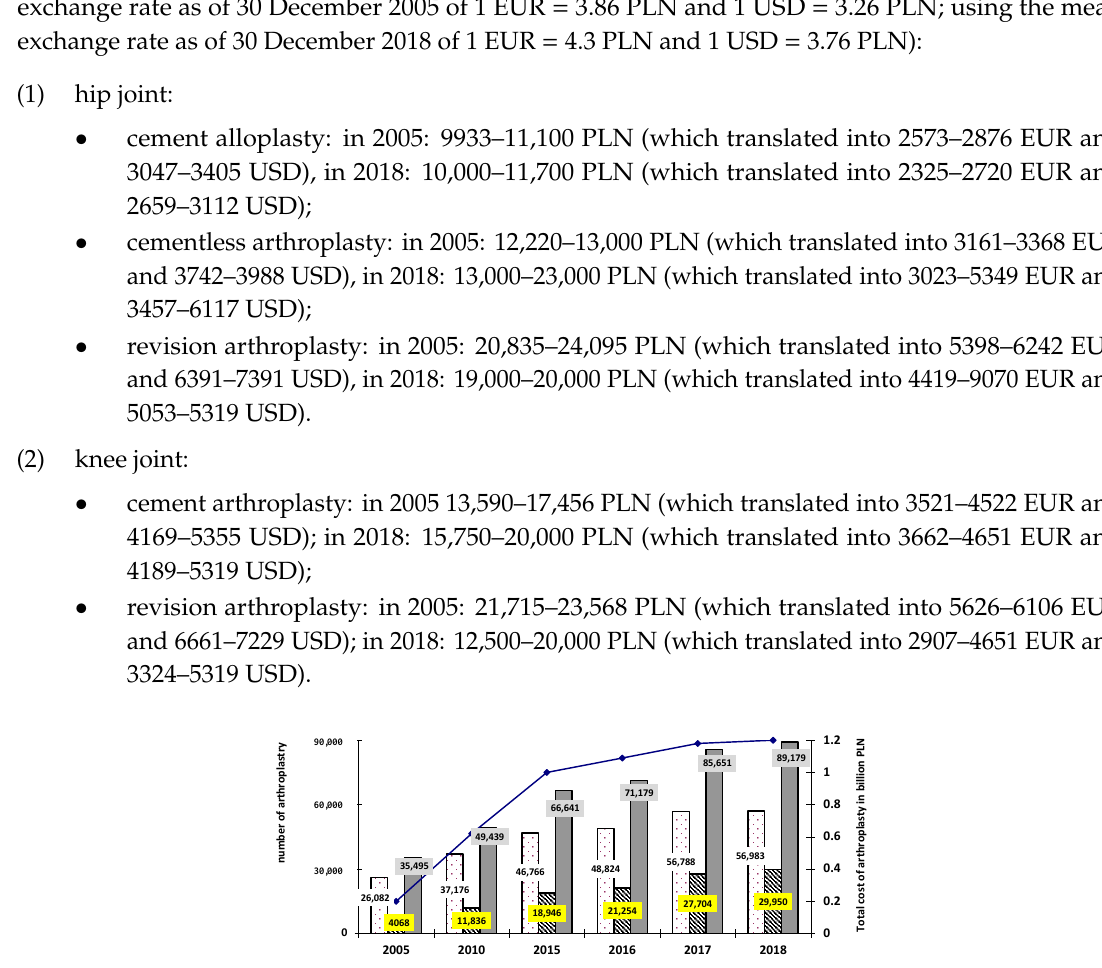
Figure 4. Number of joint replacement surgeries performed in 2018 per voivodeship in Poland (author’s own study based on [14]). The costs of joint replacement surgeries in Poland were also growing, from 0.2 billion PLN in 2005 to over 1.2 billion PLN in 2018 [8–14]. Figure 5 presents the number and costs of joint replacement surgeries performed in 2005–2018. In Poland, the costs of individual types of joint replacement surgeries in 2005–2018 were on average (author’s own study based on [8–14, 39, 40]; using the mean exchange rate as of 30 December 2005 of 1 EUR = 3.86 PLN and 1 USD = 3.26 PLN; using the mean exchange rate as of 30 December 2018 of 1 EUR = 4.3 PLN and 1 USD = 3.76 PLN):